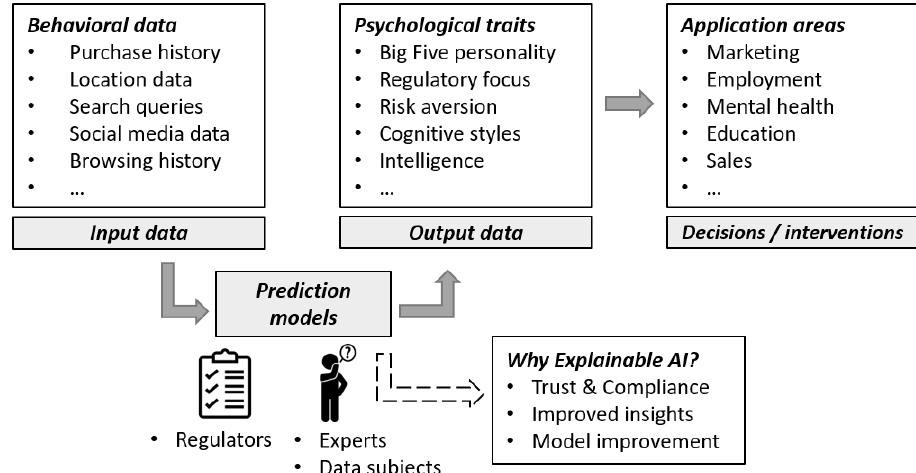
Figure 1. Explainable AI in applications that leverage behavioral data for psychological